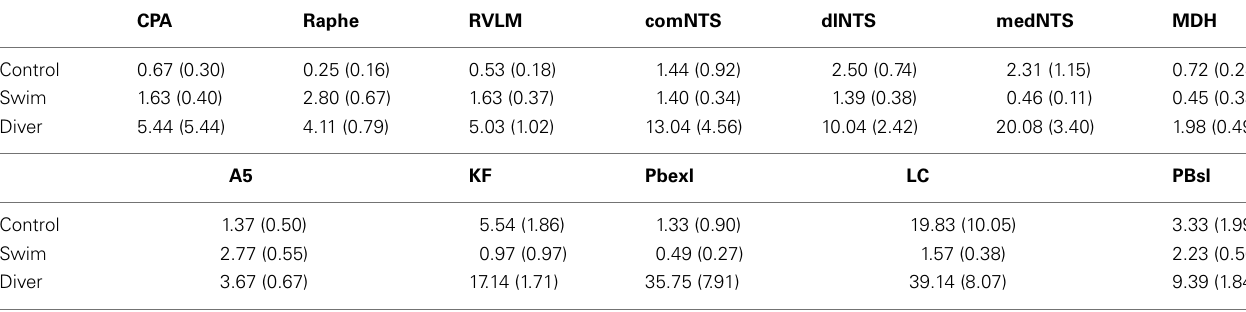
Counts of data points after thresholding of neurons immunolabeled with c-Fos in various brainstem nuclei in resting rats (control), swimming rats, and diving rats. Means